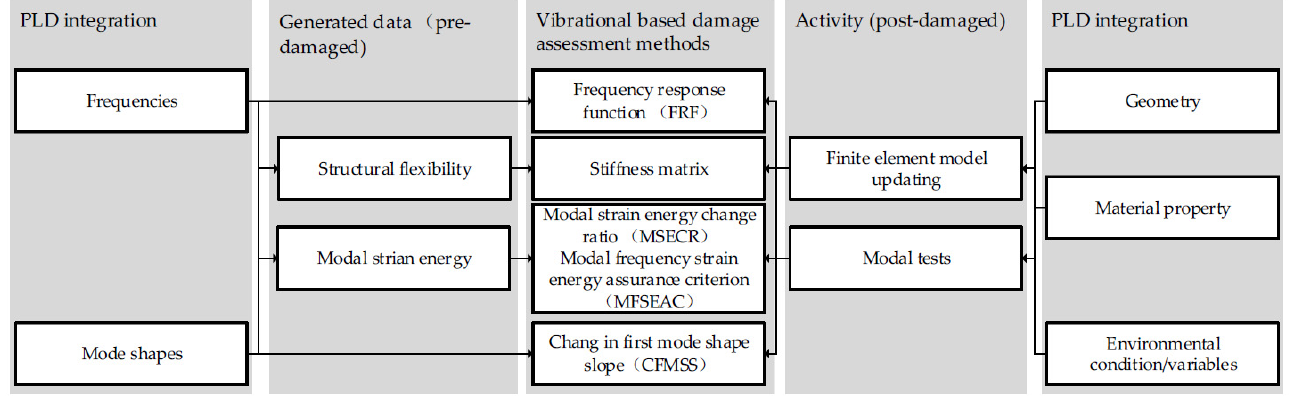
Figure 2. Integration of vibrational-based damage assessment methods and